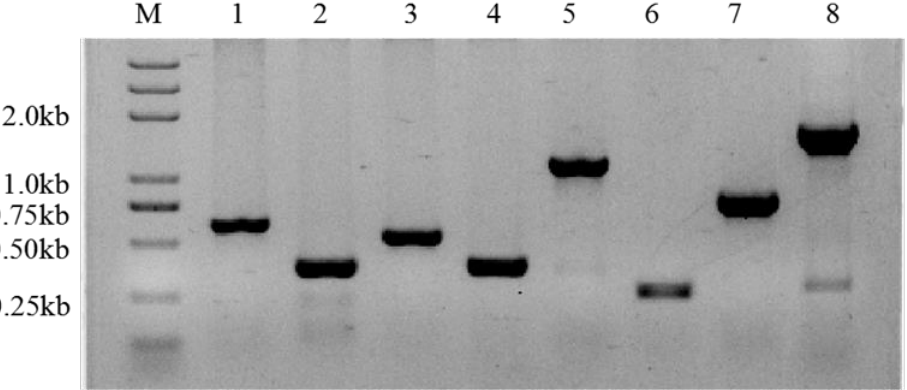
Figure 5. Amplification of extracellular polysaccharide-producing genes. M, marker; 1, gene #152; 2, gene #1371; 3, gene #3901; 4, gene #1802; 5, gene #2164; 6, gene #4312; 7, gene #7310; 8, gene #2936.